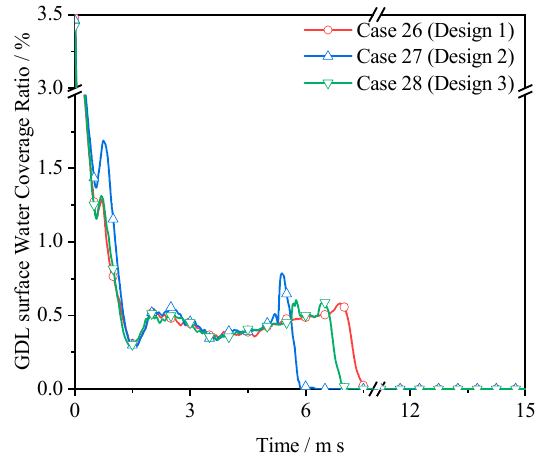
Figure 14. GDL surface water coverage ratio for multiple droplets of different sizes (r = 200 μ m, 250 μ m and 250 μ m) at an inlet velocity of 10 ms -1 and contact angle θ GDL = 120°, θ side; top = 82°; 82°, respectively.